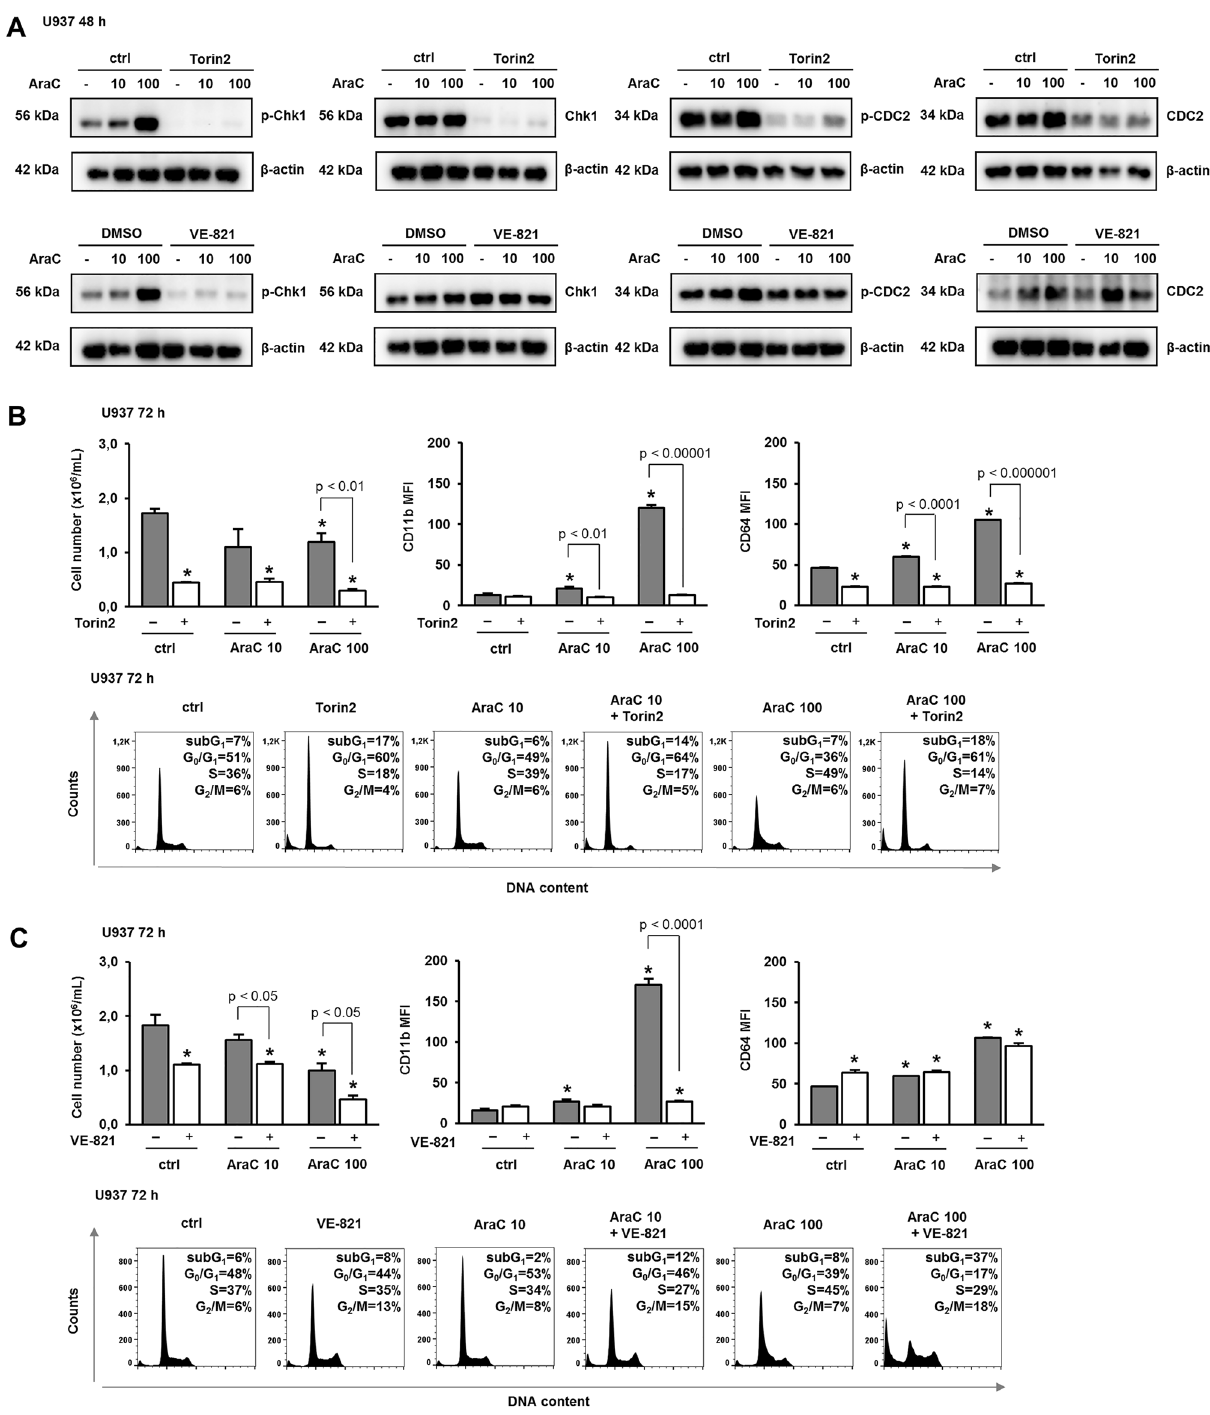
Figure 3. Pharmacological inhibition of ATR/Chk1 pathway prevents differentiation and cell cycle arrest. U937 cells were grown in the presence of increasing concentrations of AraC (10, 100 nM). Torin2 (100 nM), VE-821 (10 µM) or vehicle (DMSO) were added 30 min before the addition of AraC. (A) Total cell lysates were isolated after 48 h and analyzed by Western blotting for the level of Ser-345-phosphorylated Chk1, total Chk1, Tyr-15- phosphorylated CDC2 and total CDC2. Representative immunoblots from three independent experiments are shown. ( B – C ) The number of viable cells, the expression of differentiation markers and the cell cycle progression were determined for Torin2 (B) and VE-821 (C) pre-treated cells as described under “Methods” section. Results are mean ± S.E. (error bars) of at least three independent experiments. *, p < 0.05 (Student’s t -test) compared with control